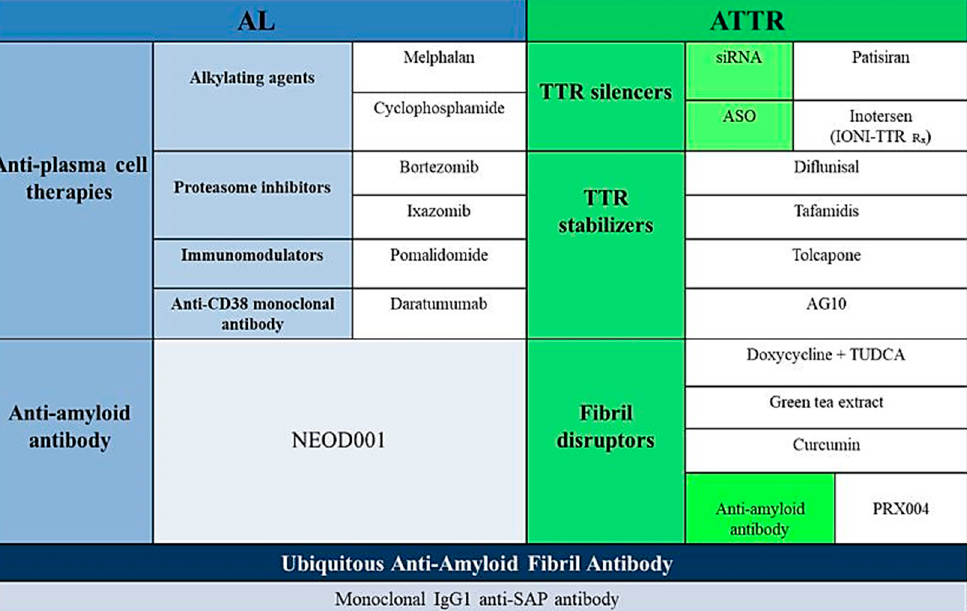
Figure 2. Amyloid-specific pharmacotherapies.